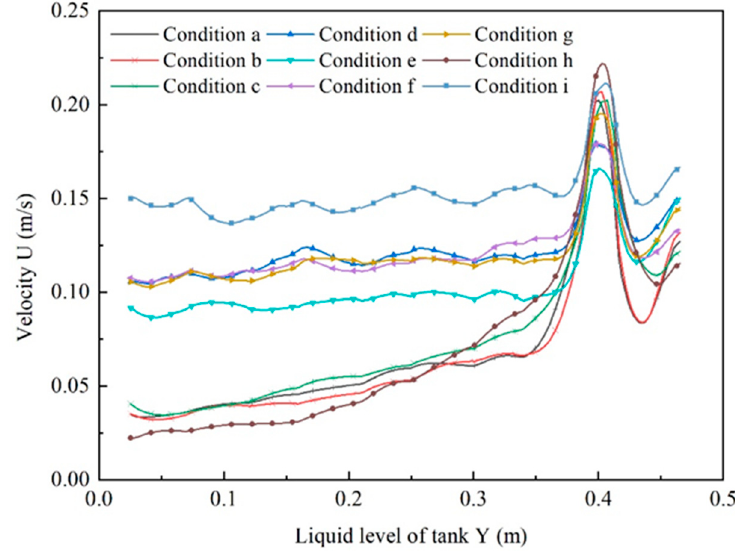
Figure 5. Distribution of liquid resultant velocity value at different heights of pickling container under different conditions (a–i).